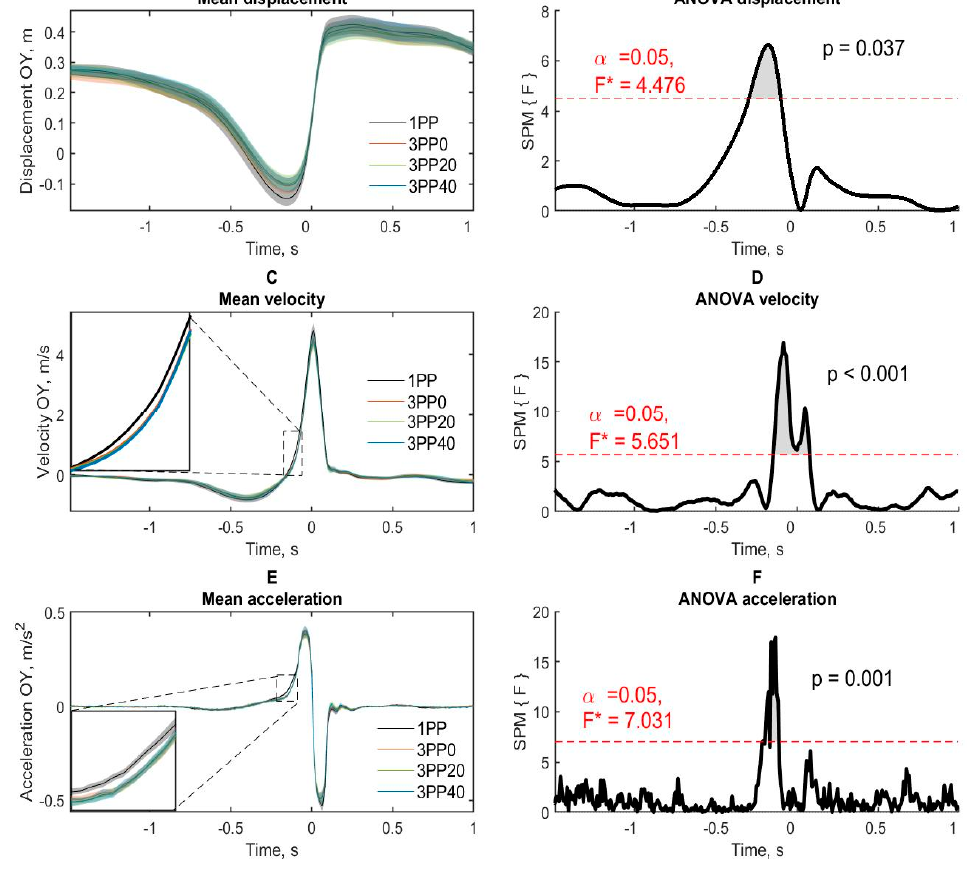
Figure 4. The right-hand kinematic data along the OY axis. A, C, E. Displacement, velocity and acceleration of the right hand in four conditions of throws. Semi-transparent areas around lines are standard errors of the mean. B, D, F. ANOVA effects of the condition. Red dashed lines denote the statistically significant level (with familywise error rate (FWER) correction). 1PP—first-person condition, 3PP0—third-person perspectives with 0°, 3PP20—third-person perspective with 20° and 3PP40—third-person perspective with 40°. Time 0 represents the moment of peak velocity of the right hand moving along the OY axis (along the direction of the throw).